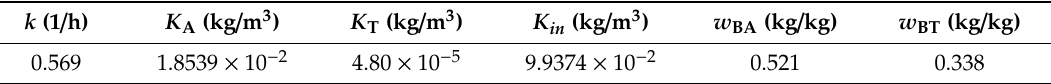
Table 1. Kinetic parameters of aerobic degradation of phenol by Pseudomonas putida [19]. k (1 / h) K A (kg / m 3 ) K T (kg / m 3 )